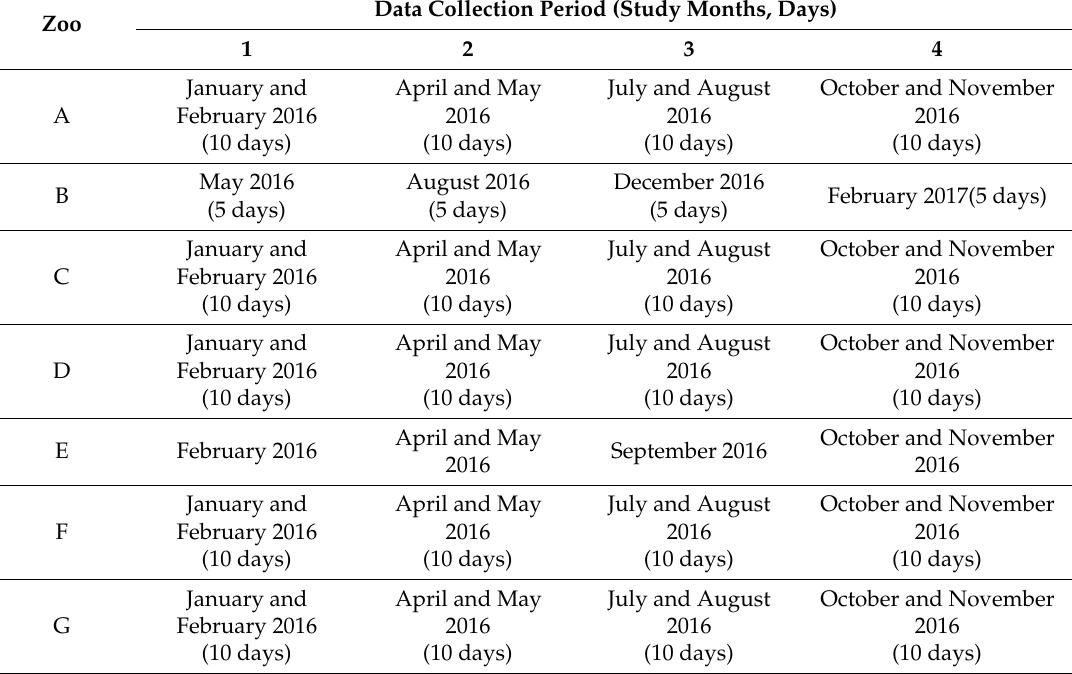
Table 2. Data collection periods for each study zoo.